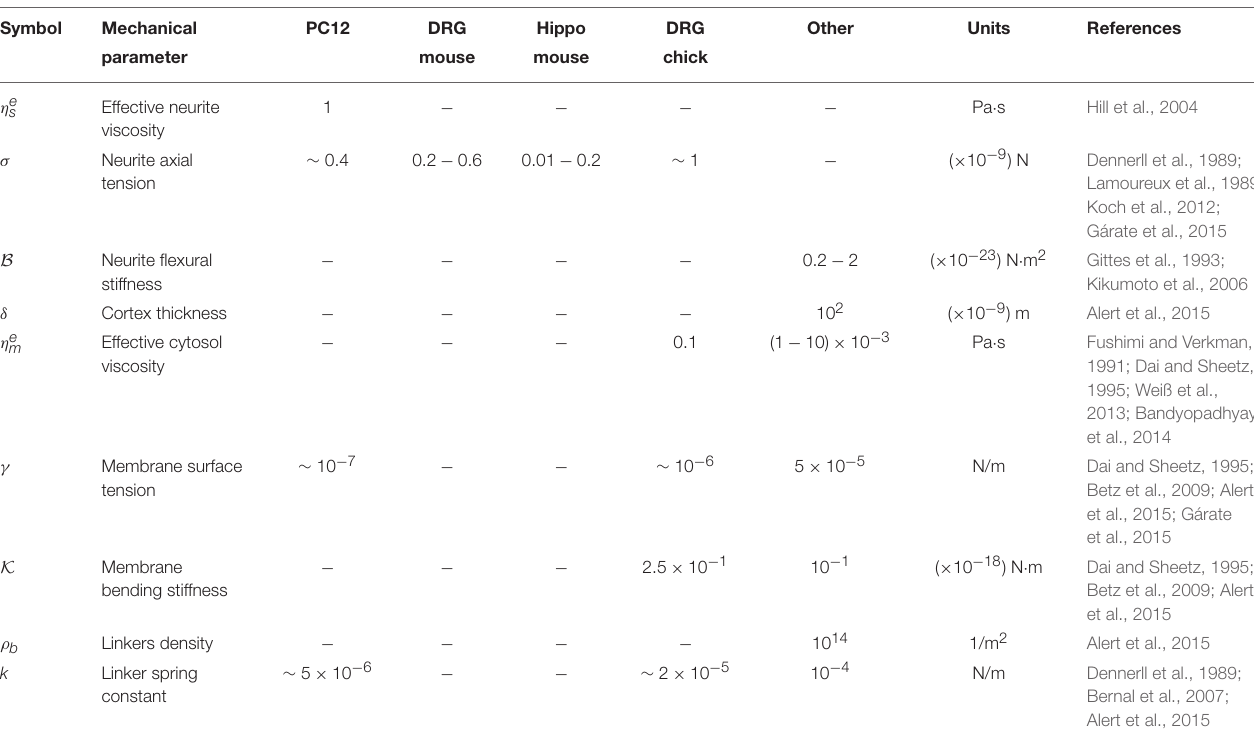
Symbol Mechanical